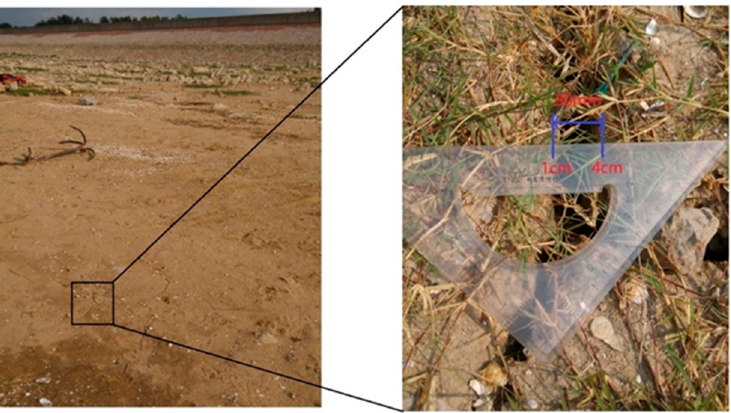
Figure 4. Cracks with maximum width of 30 mm on the upstream slope.